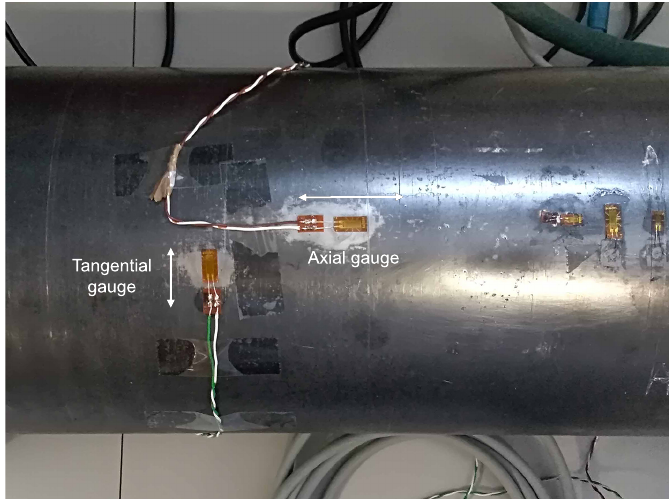
Figure 9. Strain